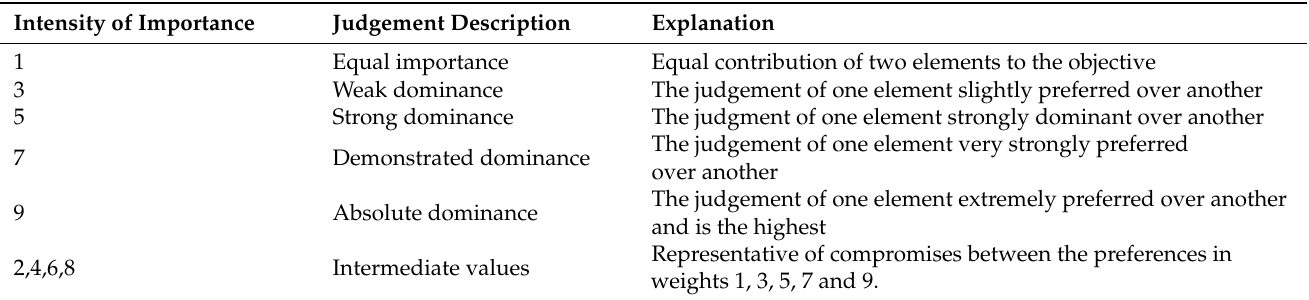
Table A2. AHP-Saaty’s pairwise comparison scale [41].